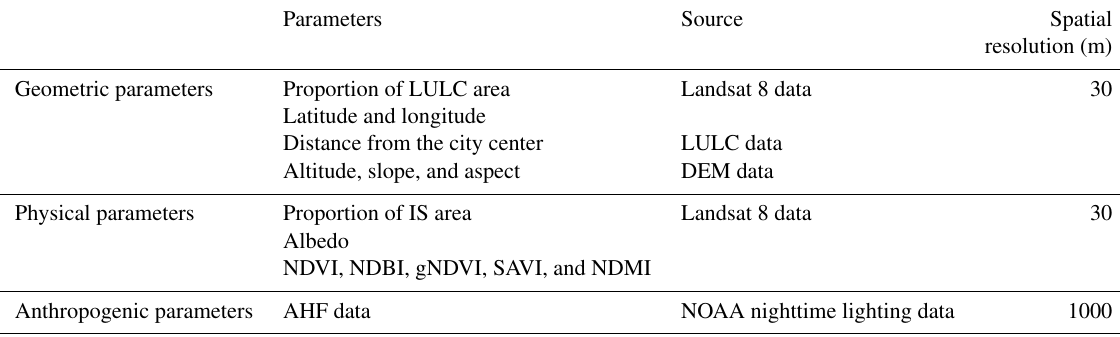
Table 1. Independent variables with their sources and spatial